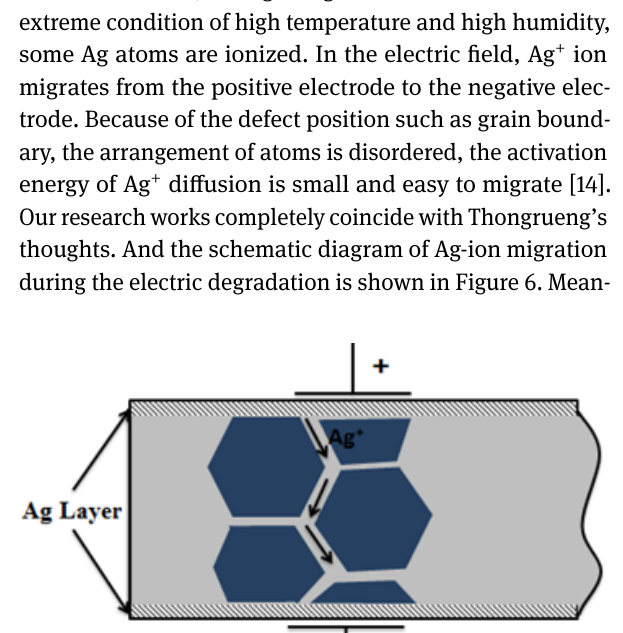
some electric domains are polarized to translate from a rhombohedral to a rhombohedral phase.